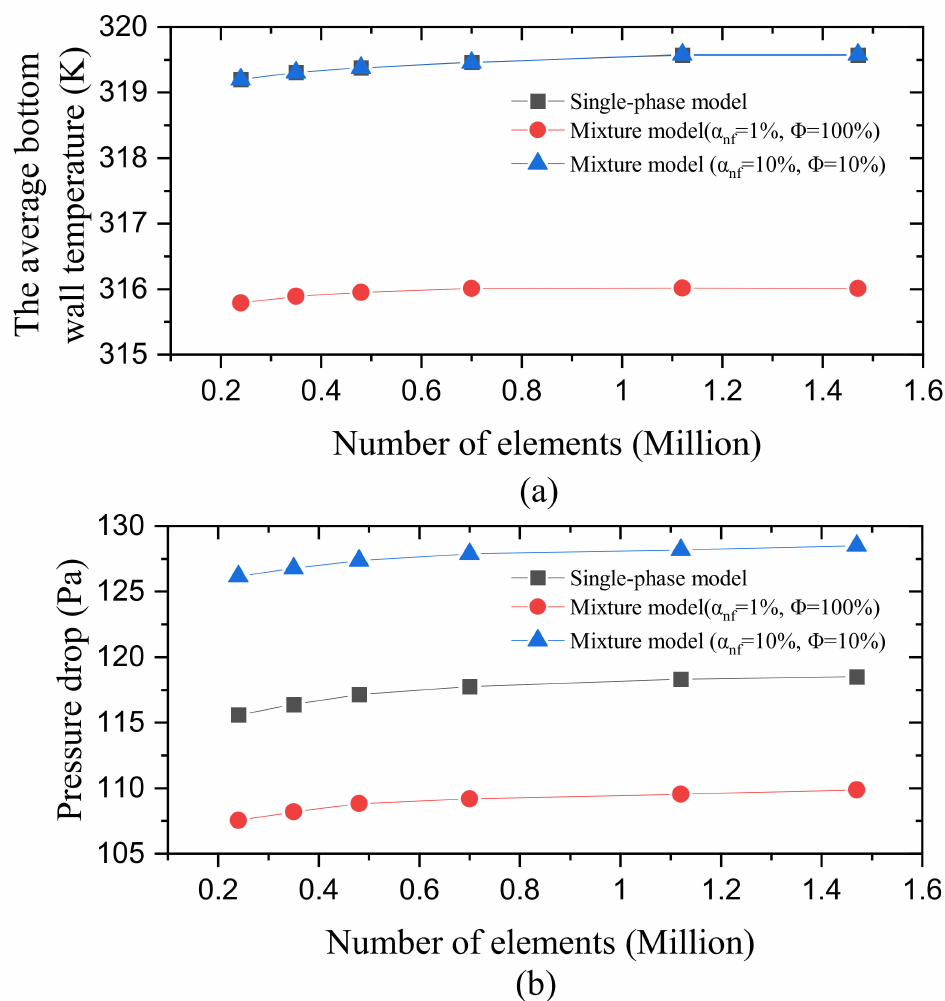
Figure 4. Mesh dependence of ( a ) the average minichannel bottom wall temperature and ( b ) the inlet to outlet pressure drop.